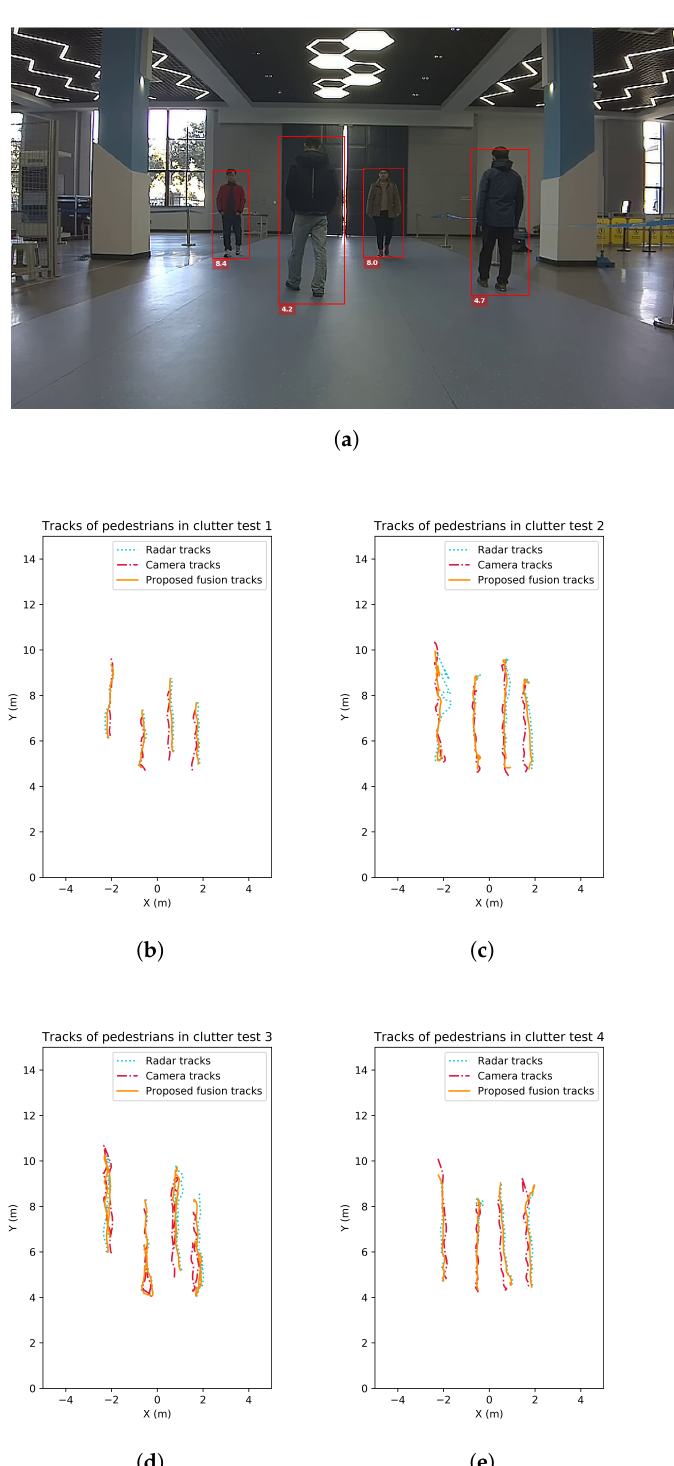
Figure 11. Pedestrian tracking performance of 4 tests by 4 tracking targets in clutter with different char- acteristics. ( a ) Camera captures of the test scene. ( b ) Tracking trajectories for test 1. ( c ) Tracking trajectories for test 2. ( d ) Tracking trajectories for test 3. ( e ) Tracking trajectories for test